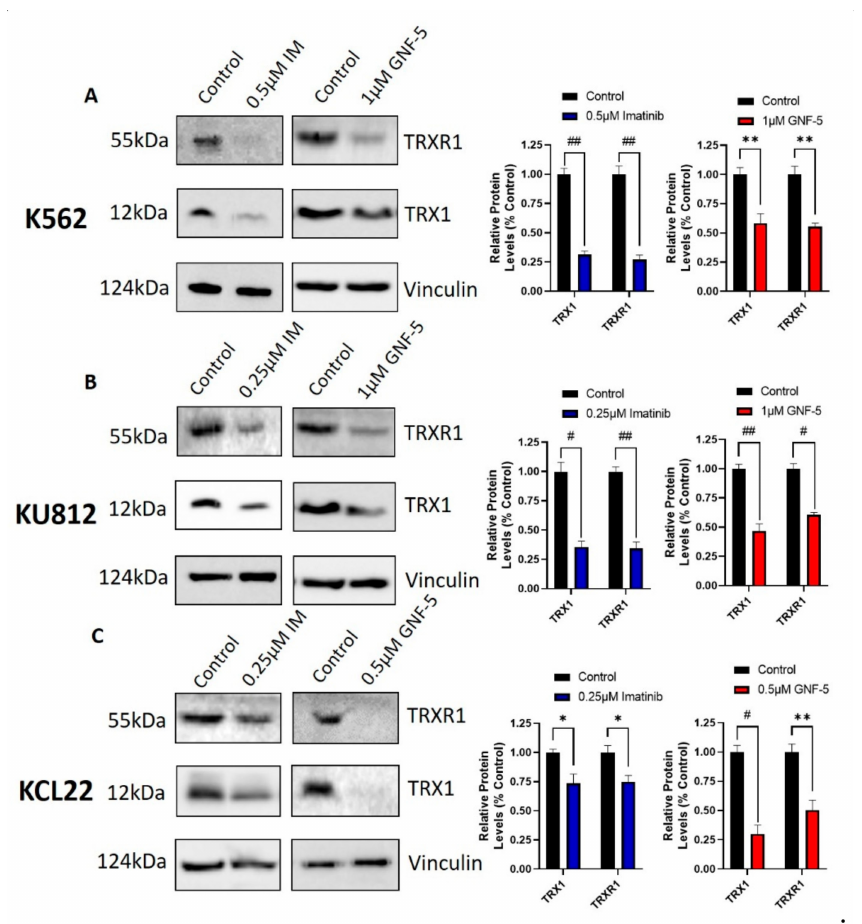
Figure 6. TKIs affect the protein expression levels of components of the TRX system. K562 ( A ), KU812 ( B ) and KCL22 ( C ) CML cells were treated with either imatinib or GNF-5 for 72 h. Following this, Western blotting was used to measure TRX1 and TRXR1 protein levels. Densitometry analysis of Western blots is displayed as mean ± SD and was statistically analyzed via paired t tests. Vinculin was used as a loading control. * = p < 0.05, ** = p < 0.01, # = p < 0.001, ## = p < 0.0001. n =